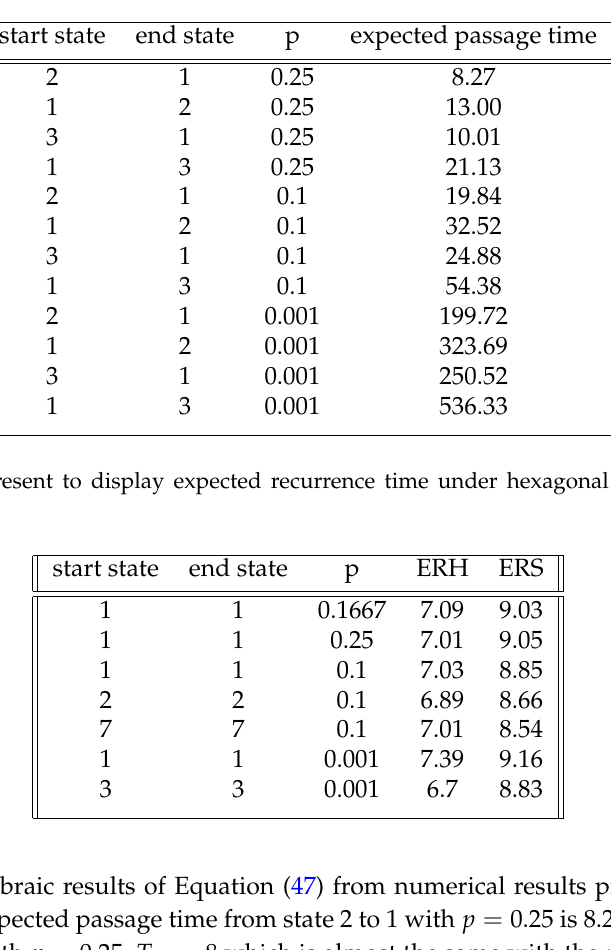
Table 2. A table to represent the effect of changing the value of parameter p on expected passage time from one state to another under square small cell complex